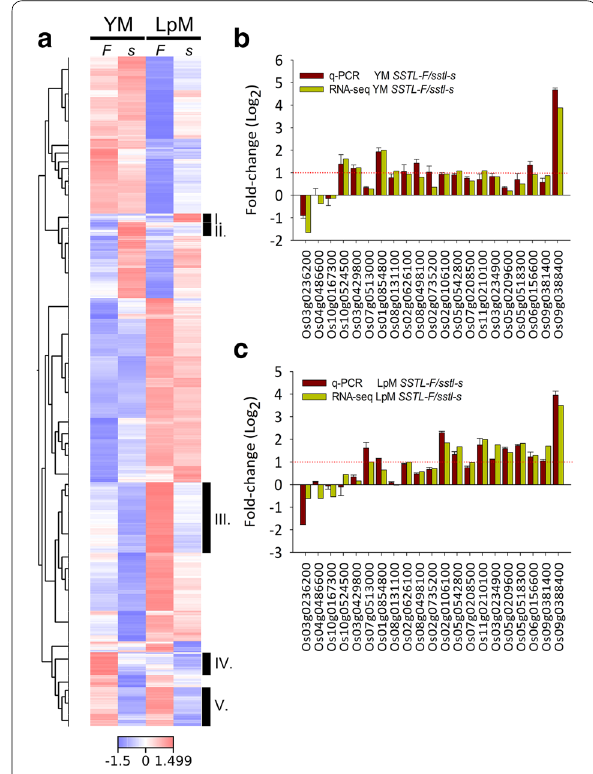
Heat‑map analysis of RNA‑seq data in YM and LpM stage for fertile and sterile anthers. b Relative contribution of fold changes between RNA‑seq and qPCR data in YM and c LpM. Gene expression of q‑PCR data normalized to that of OsUBI , OsACT11 , OsUBQ5 , and eEF ‑ 1α . YM young microspores stage, LpM late pollen mitosis stage, I a cluster with specific upregulated genes of sstl ‑ s in LpM, II a cluster with specific upregulated genes of sstl ‑ s in YM, III a cluster with specific upregulated genes of SSTL ‑ F in LpM, IV a cluster with specific upregulated genes of SSTL ‑ F in YM, V a cluster of SSTL ‑ F upregulated genes in both YM and LpM stages, F fertile, s sterile. Data are mean ±